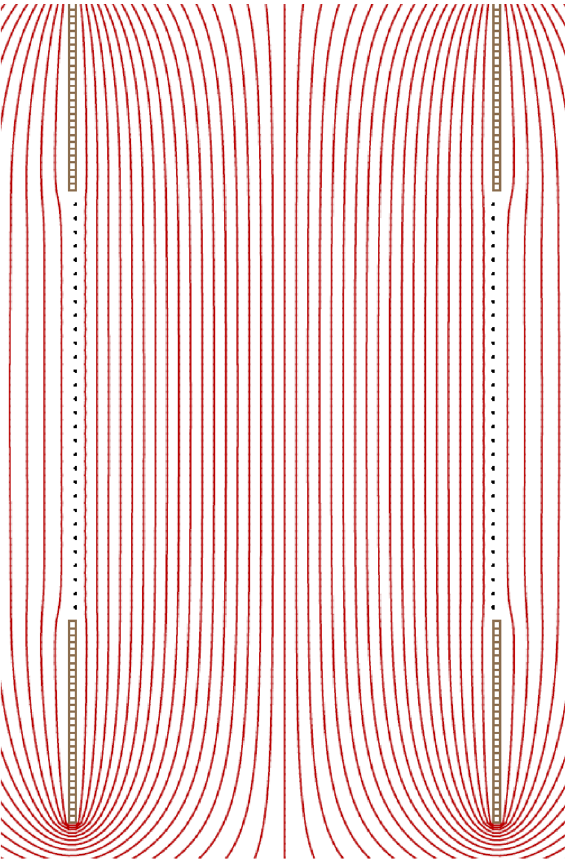
) and vertical ( Q x